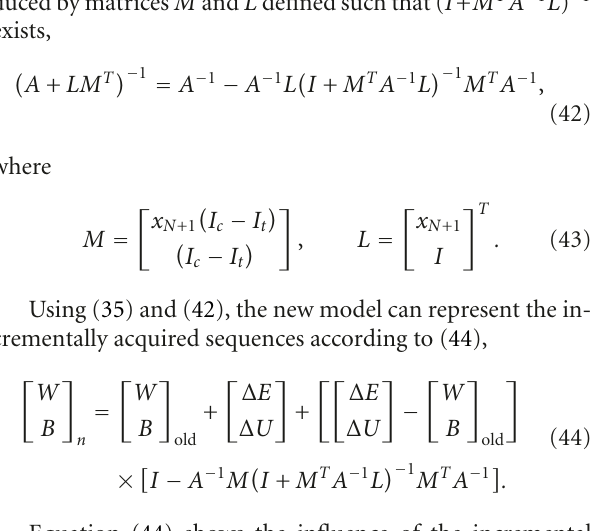
Equation (44) shows the influence of the incremental data on calculating the new separating hyperplane slopes and intercept values for the di ff erent c